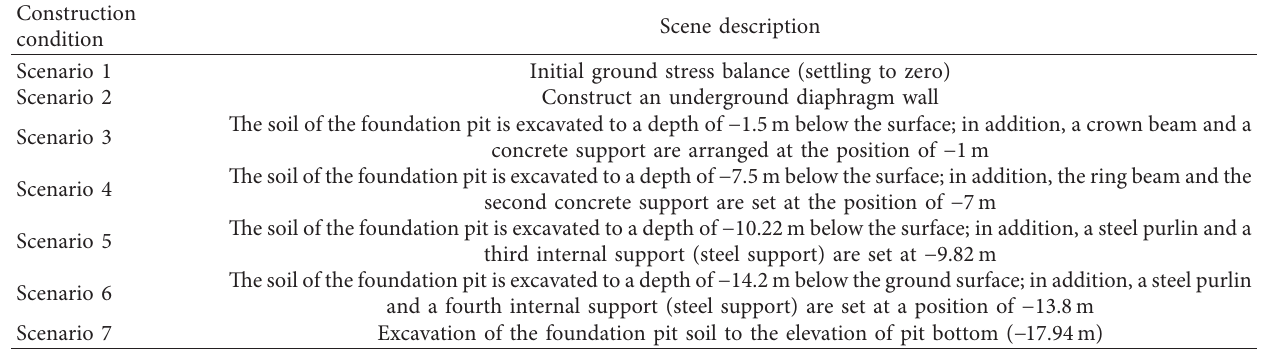
Table 4: Simulated construction condition of deep foundation pit excavation.